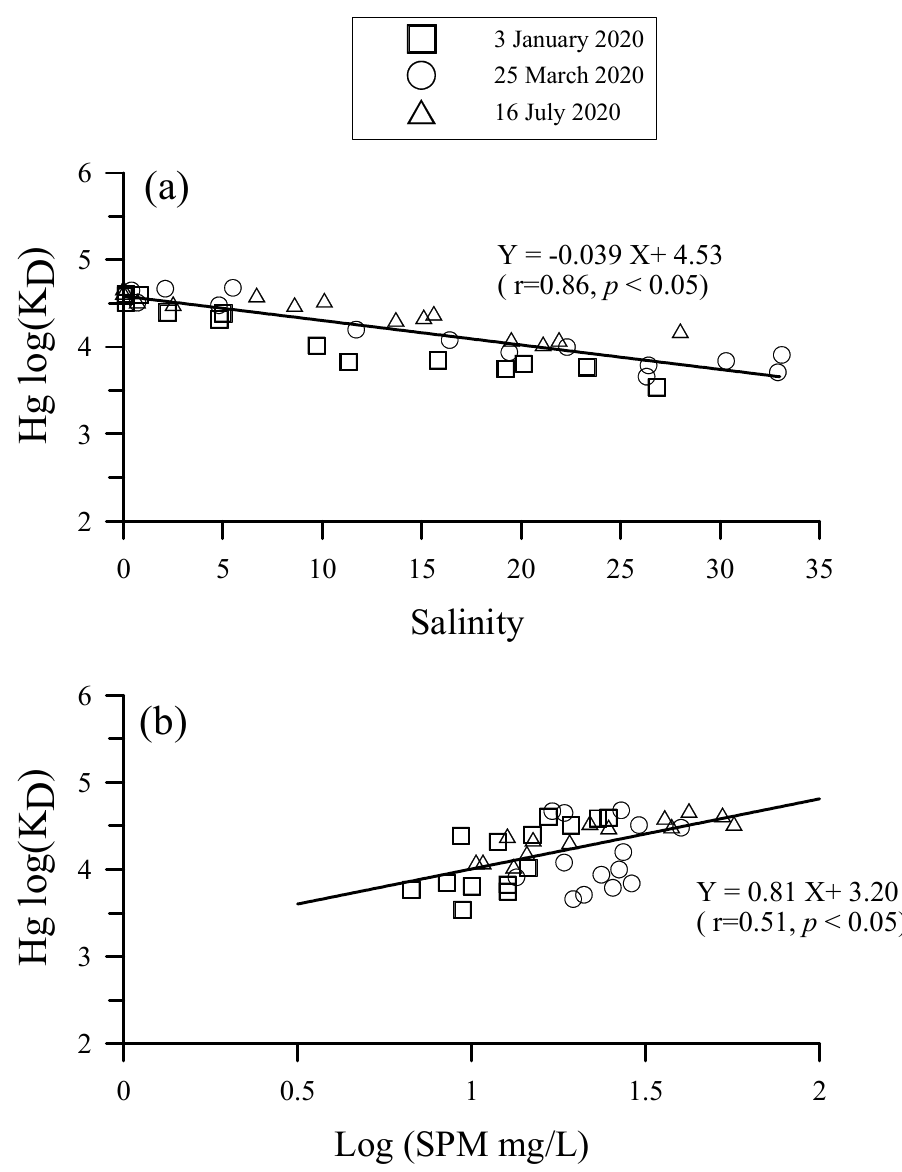
Figure 7. Scatter plots of log(K D ) value for Hg ( a ) against salinity ( b ) against log(SPM) concentration in the Danshuei River Estuary, northern Taiwan.